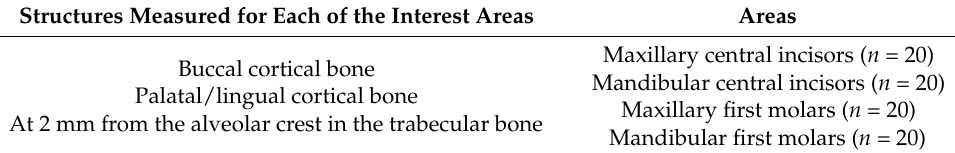
Table 3. Structures and areas of interest: for each area, three measurements were performed at the structures level. Structures Measured for Each of the Interest Areas Areas Buccal cortical bone Palatal/lingual cortical bone At 2 mm from the alveolar crest in the trabecular